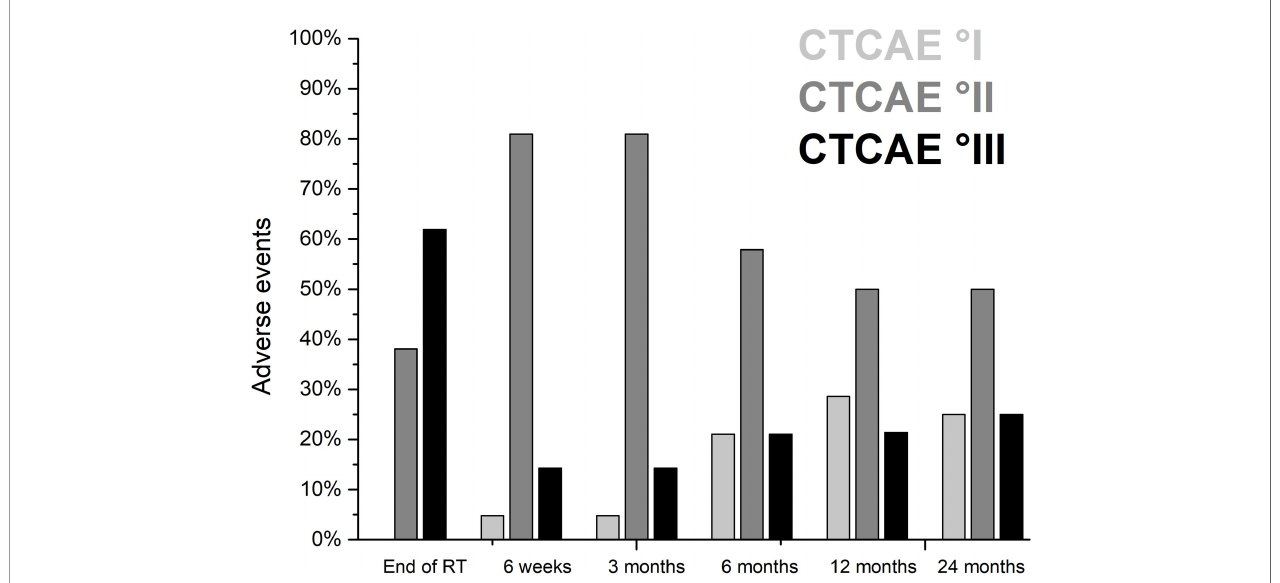
FIGURE 1 | Acute and late adverse events after de fi nitive radiotherapy of 21 patients with malignant tumors involving the nasal vestibule irradiated with CIRT-B combined with VMAT according to common toxicity criteria for adverse events (CTCAE V